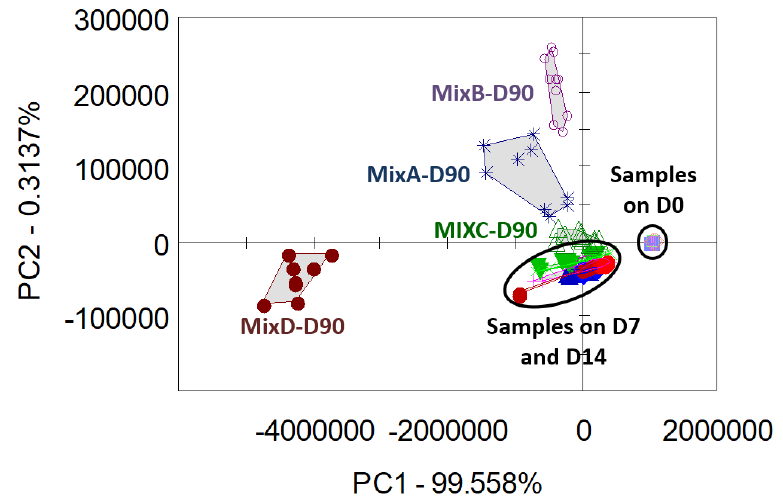
Figure 2. PCA score plot of the aroma profile of all (4) mixtures (mixture A, B, C and D) measured on all (4) days (Day 0, 7, 14, 90). mixture A: 40% of two cultivars of winter triticale + 30% of two cultivars of winter oats + 20% of winter barley + 10% of winter wheat; mixture B: 50% of two cultivars of winter triticale + 40% of winter barley + 10% of winter wheat; mixture C: 55% of three types of Italian ryegrass + 45% of two cultivars of winter oat; mixture D: 40% of three types of Italian ryegrass + 30% of two cultivars of winter oat + 15% of two cultivars of winter triticale + 10% of winter barley + 5% of winter wheat.